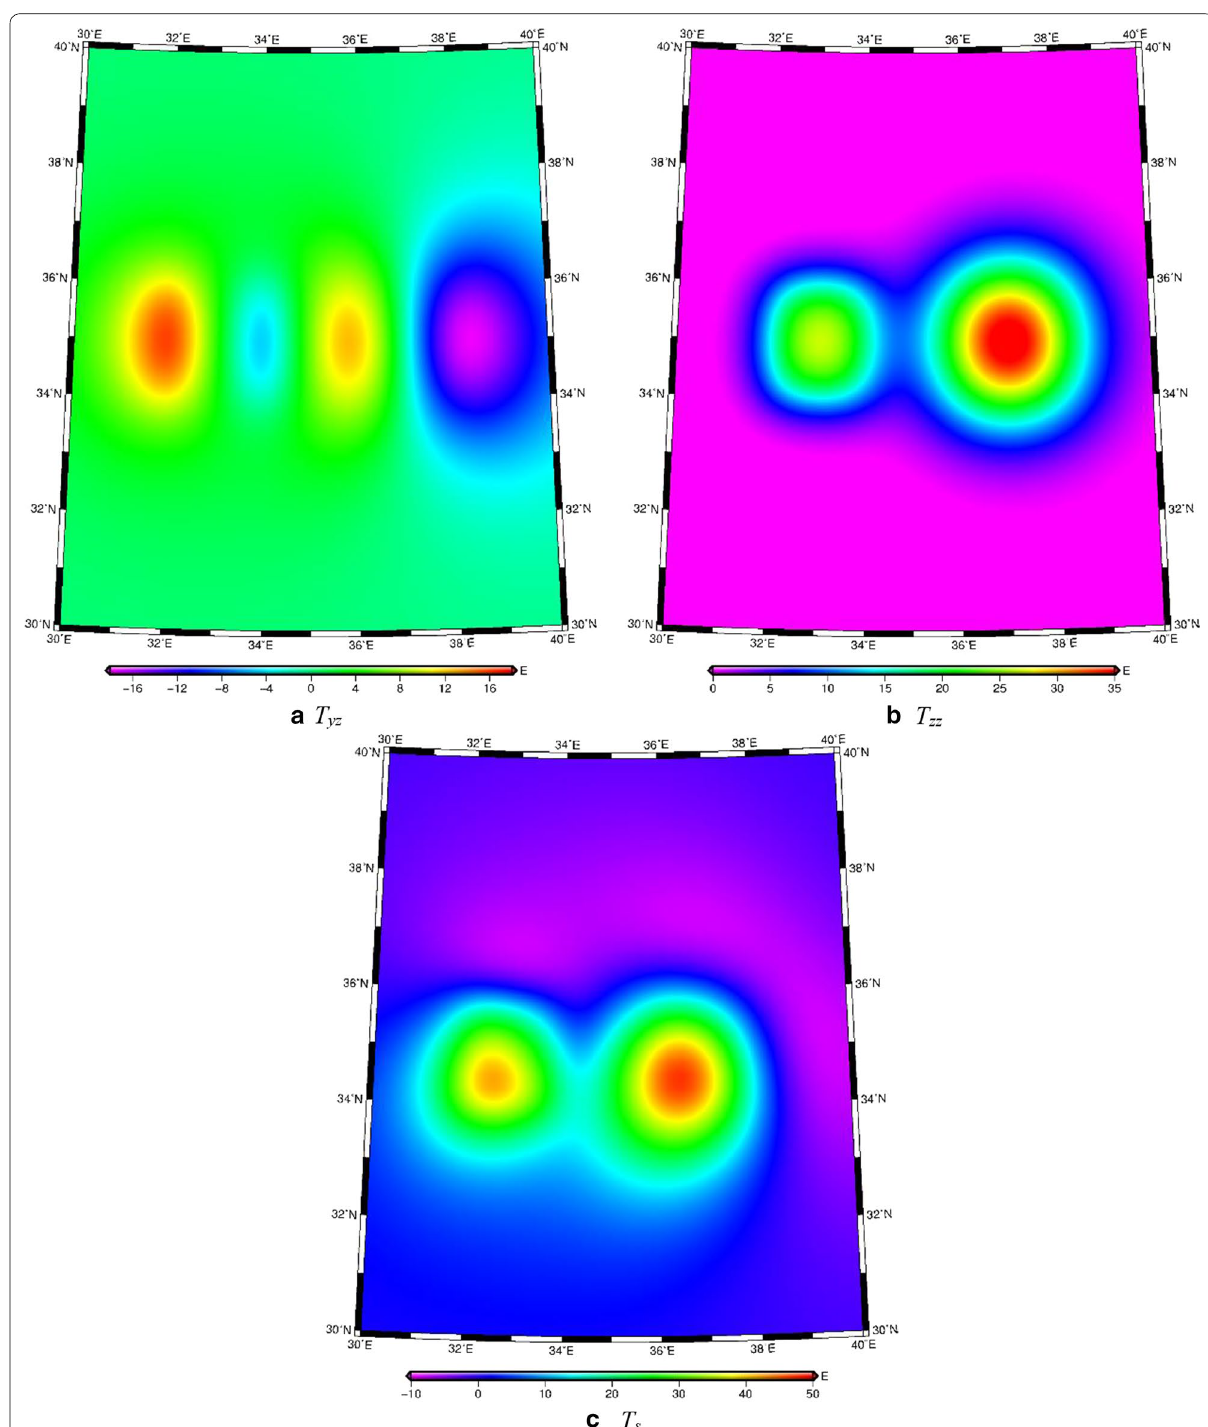
Fig. 10 Artificial theoretical datasets of the GGT for composite models, a and b are T yz and T zz components of the GGT, respectively, and c T s is the summation of T xx , T xy , T xz , T yy , T yz and T